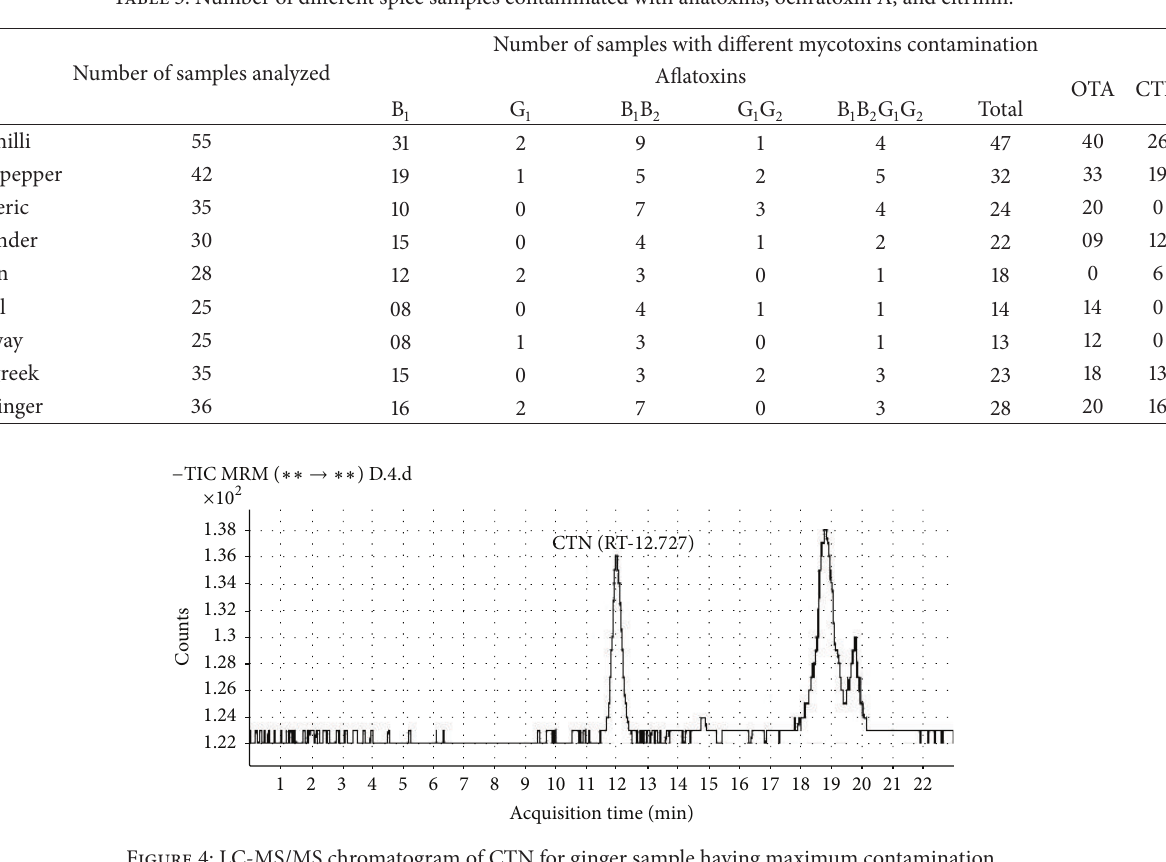
Table 3: Number of different spice samples contaminated with aflatoxins, ochratoxin A, and citrinin.